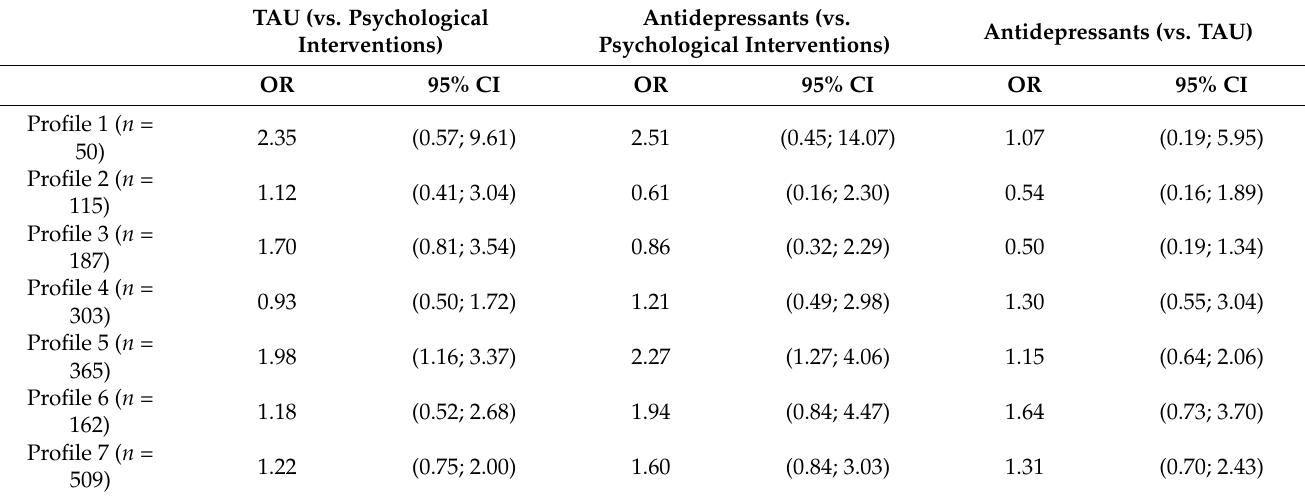
Table 7. Association between treatment type and a continued chronic course of depression within each profile. TAU (vs. Psychological Antidepressants (vs. Antidepressants (vs. Interventions) Psychological Interventions)